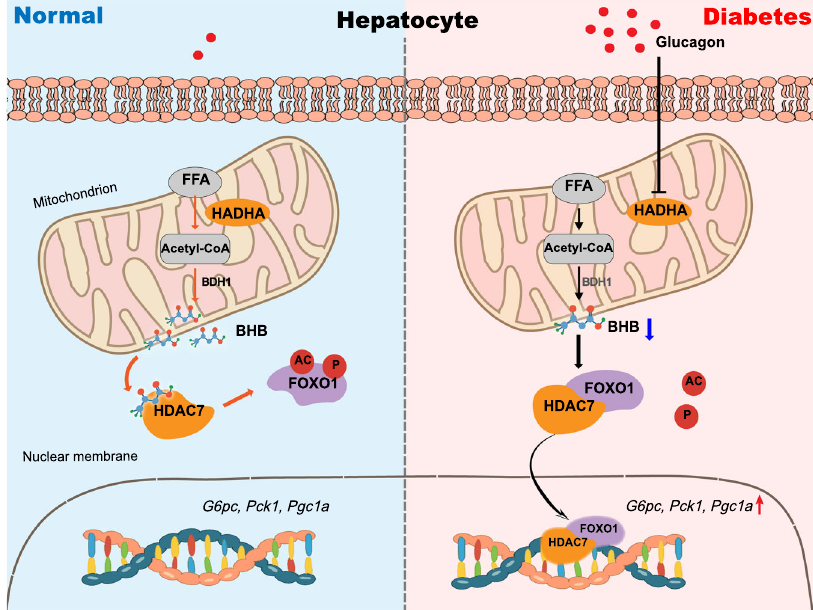
Fig. 8 Scheme of the role for HADHA in promoting BHB production to restrain hepatic gluconeogenesis. In normal state, hepatic HADHA facilitates ketogenesis from fatty acid β -oxidation. BHB, a predominant ketone body which is dependent on upstream HADHA expression, plays a key role in regulating gluconeogenic genes and hepatic glucose production. Mechanism-wise, BHB can bind to HDAC7 and inhibit its activity, thus preserving FOXO1 acetylation and phosphorylation. In diabetes, excess glucagon impairs HADHA expression and inhibits downstream BHB production, thereby increasing FOXO1 transcriptional activity and hepatic gluconeogenesis via HDAC7